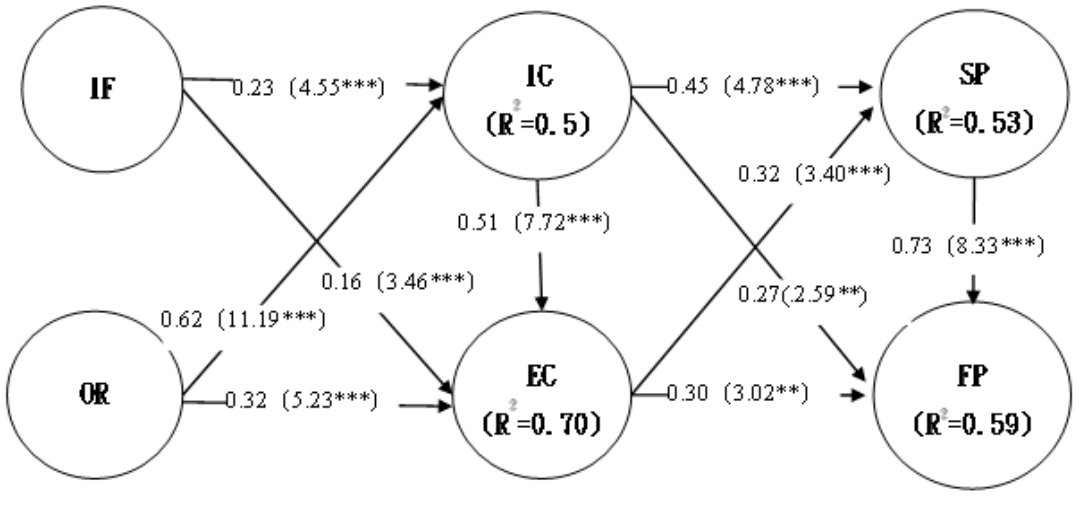
Figure 3. Mediation effect analysis; *** p <.0001; ** p <.001